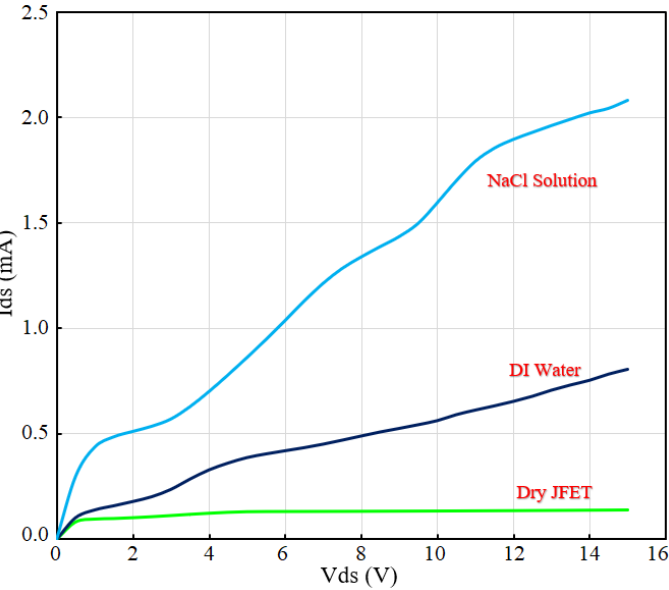
Figure 11. Preliminary test results of sensor with DI water and 0.9% NaCl solution injected in microfluidic channel.